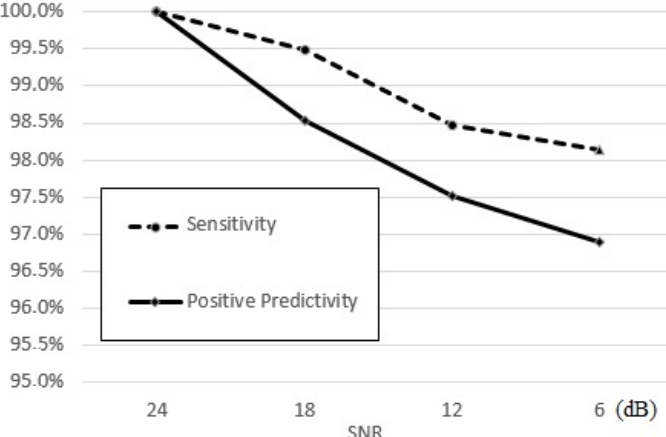
Figure 6. Algorithm behavior as a function of different signal to noise ratio (SNR) values.